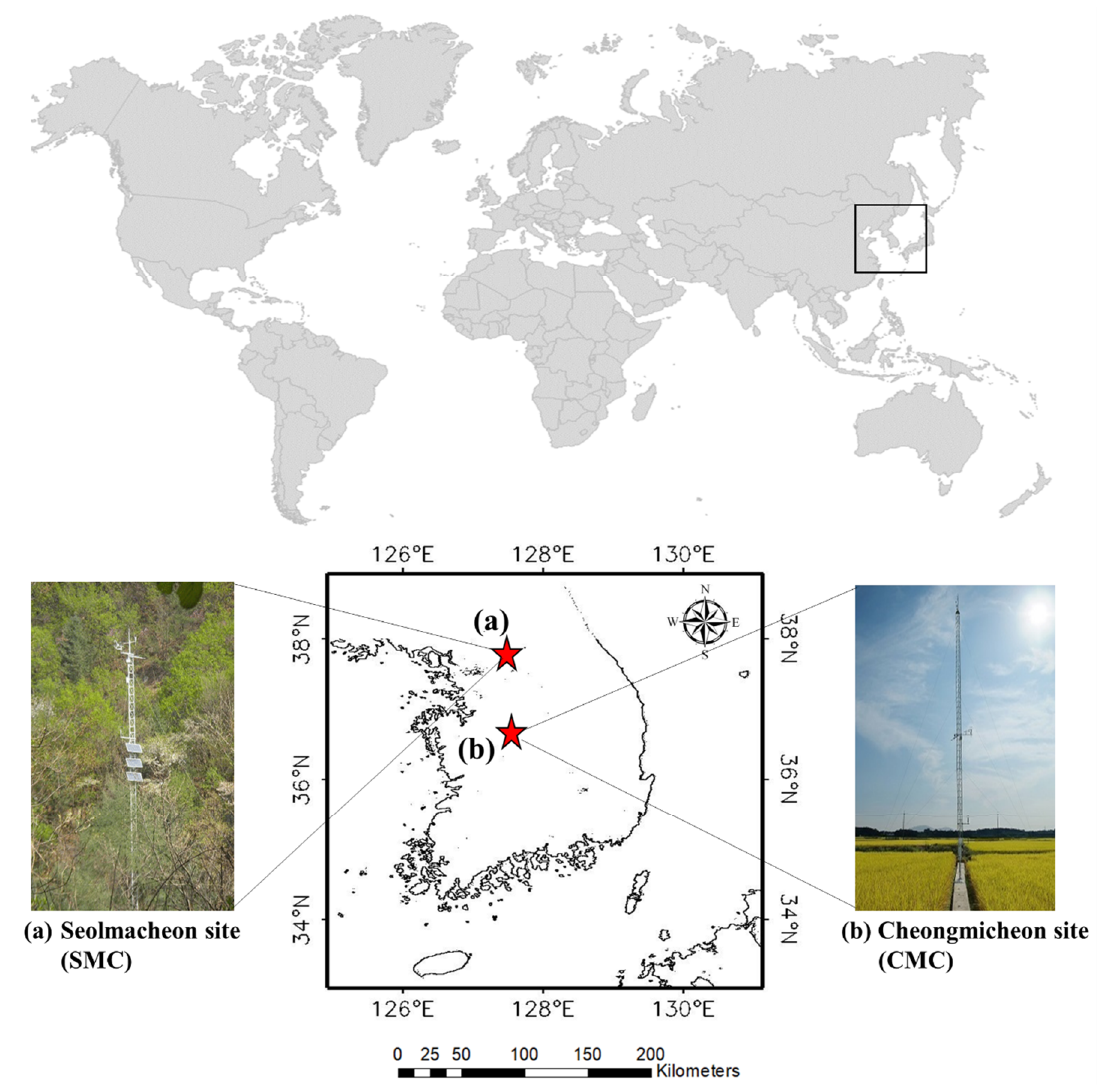
Figure 1. Geographical locations of South Korea and the two flux towers (( a ) Seolmacheon (SMC) and ( b ) Cheongmicheon (CMC) site) used in this